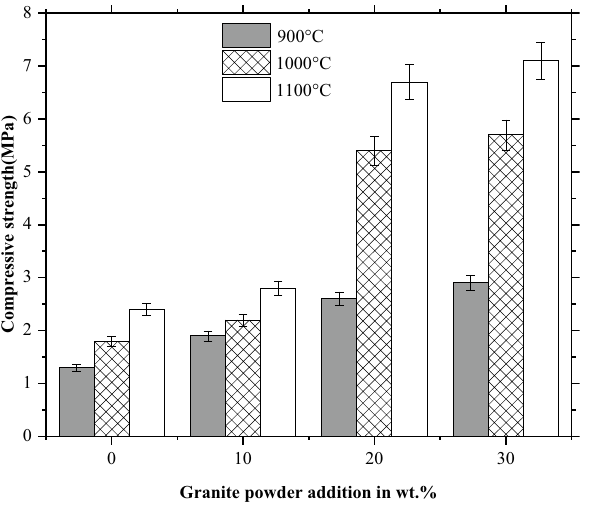
Fig. 10 Compressive strength of fired clay bricks fired at 900, 1000 and 1100